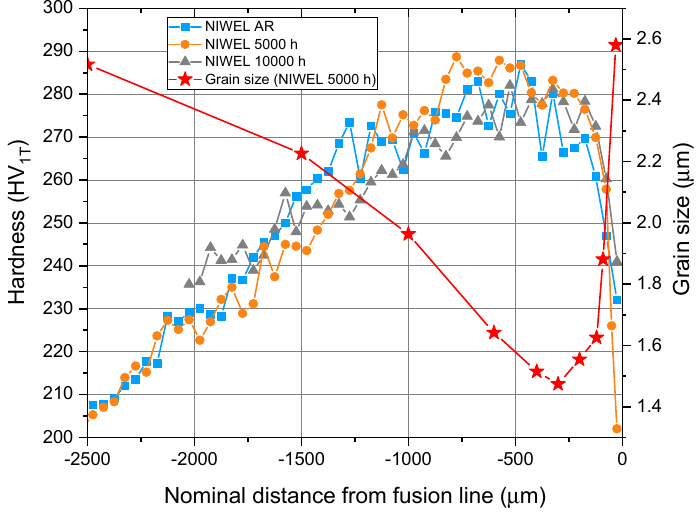
Figure 4. SEM images of the SA 508 HAZ microstructure in the NIWEL AR and NIWEL 10,000 h conditions, showing the microstructure at ( a ) 2500, ( b ) 800 and ( c ) 200 μ m from the FB in NIWEL AR condition and microstructure at ( d ) 2500, ( e ) 800 and ( f ) 200 μ m from the FB in NIWEL 10,000 h condition.